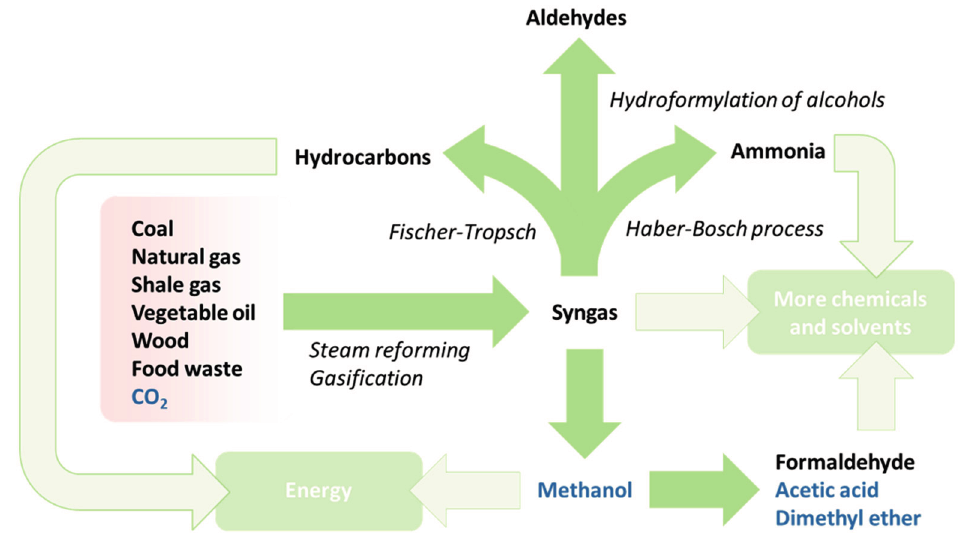
Figure 8. The extended syngas and methanol economy, with feedstocks highlighted in red and solvents in blue